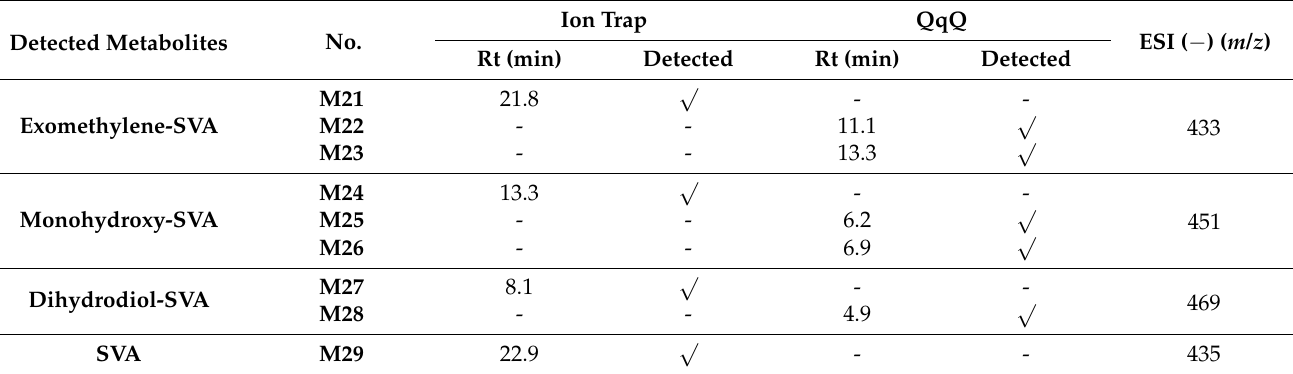
Table 2. Simvastatin metabolites detected in QqQ/ion trap–MS in negative mode.